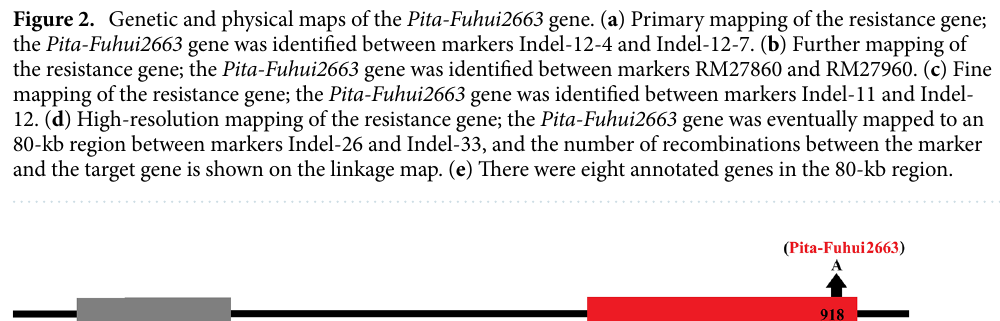
(Fig. 2e), and all genes had a corresponding full-length cDNA. LOC_Os12g18320 , LOC_Os12g18330, LOC_ Os12g18340, LOC_Os12g18350 and LOC_Os12g18400 encode retrotransposon proteins; LOC_Os12g18360 encodes an NBS-LRR protein; LOC_Os12g18390 encodes a centromere-specific protein; LOC_Os12g18400 encodes a mitochondrial iron-regulated protein (MIR); and LOC_Os12g18410 encodes a retrotransposon pro- tein and also the MIR protein.